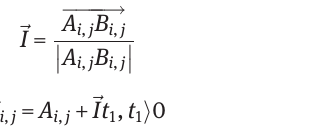
Table 1: The time of weld pool surface change from convex to concave at different currents. Experiment